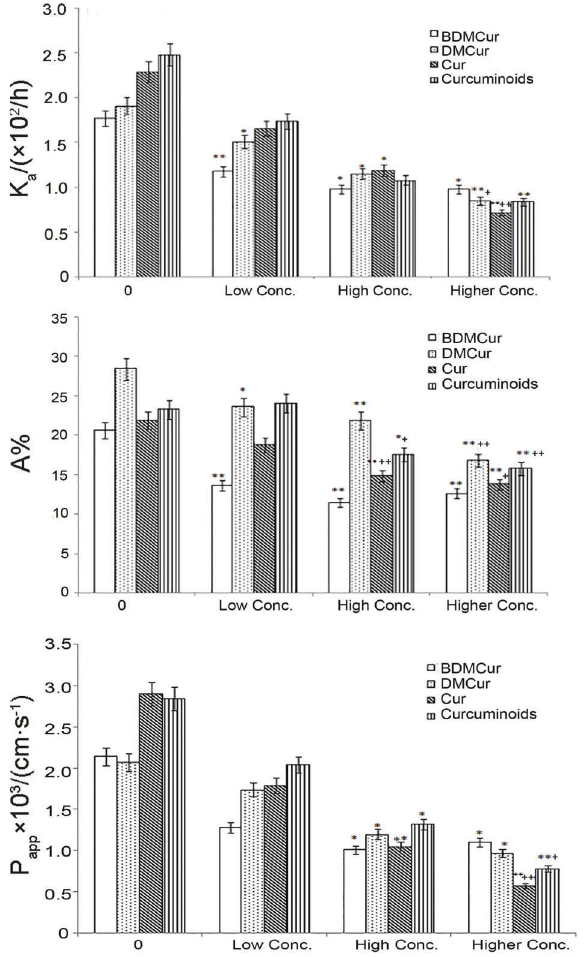
Figure 7. In fl uence of different energy inhibitor 2,4-dinitrophenol concentrations on absorption parameters of bisdemethoxycurcu- min (BDMCur), demethoxycurcumin (DMCur) and curcumin (Cur). Top : absorption rate constant (K a ); middle : absorption percentage (A%); and bottom : drug apparent absorption coef fi cient (P app ). Conc: concentration. **P o 0.01, *P o 0.05 compared to medicine group without energy inhibitor; ++ P o 0.01, + P o 0.05 compared to medicine group with low concentration of energy inhibitor